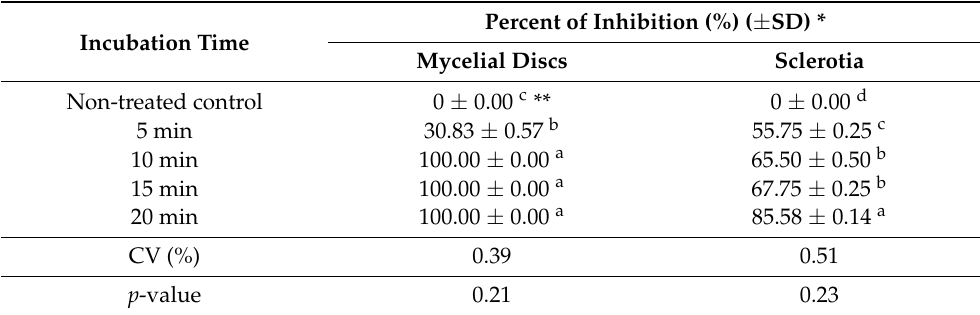
Table 1. Percentage of inhibition of Athelia rolfsii growth after exposure to DBD